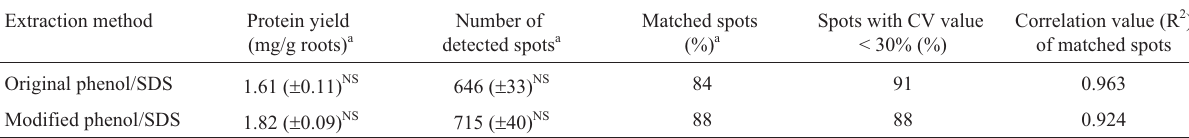
Table 1 - Recovered protein yield and reproducibility from soybean root proteins using two protein extraction methods and IPG strips (13 cm) with a lin- ear pH range 3-10. a: Values represent the means of three independent biological replicates with standard deviation in parentheses; NS: Values show no statistically significant difference (ANOVA test, p <